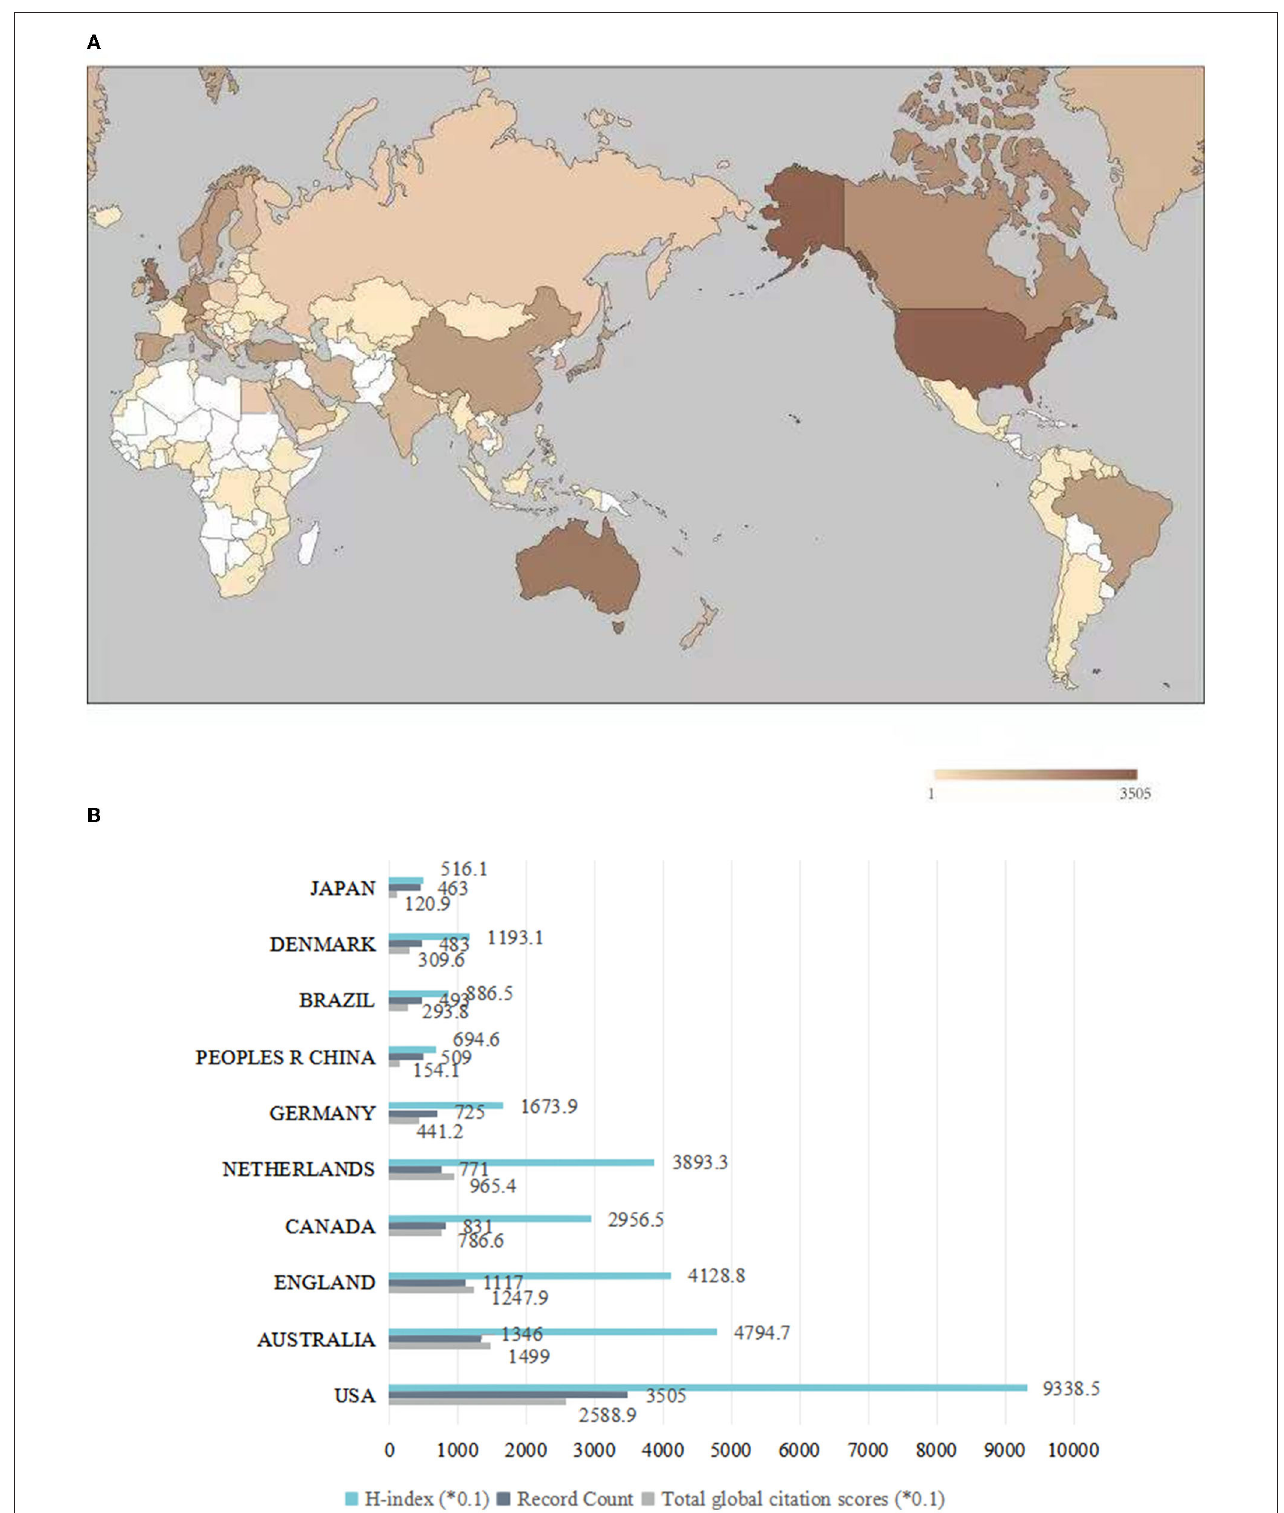
FIGURE 4 | Articles in the world related to LBP. (A) Distribution of LBP publications. (B) Number of publications, total local citation score (number of citations of country or region publications in Web of Science), and H-index among top 10 productive countries.